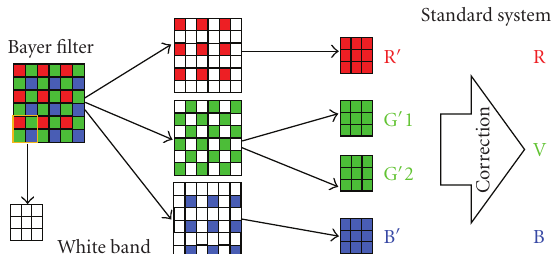
Figure 3: The schematic of the Tri-color imaging. Red, two, green, and blue filters are placed along with a Bayer arrangement on the image sensor. The W band image is made by adding the four